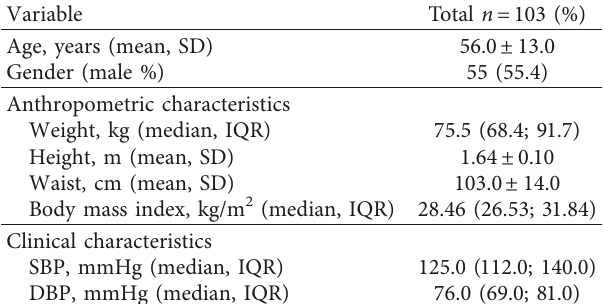
Table 1: Baseline demographic, clinical, and biochemical